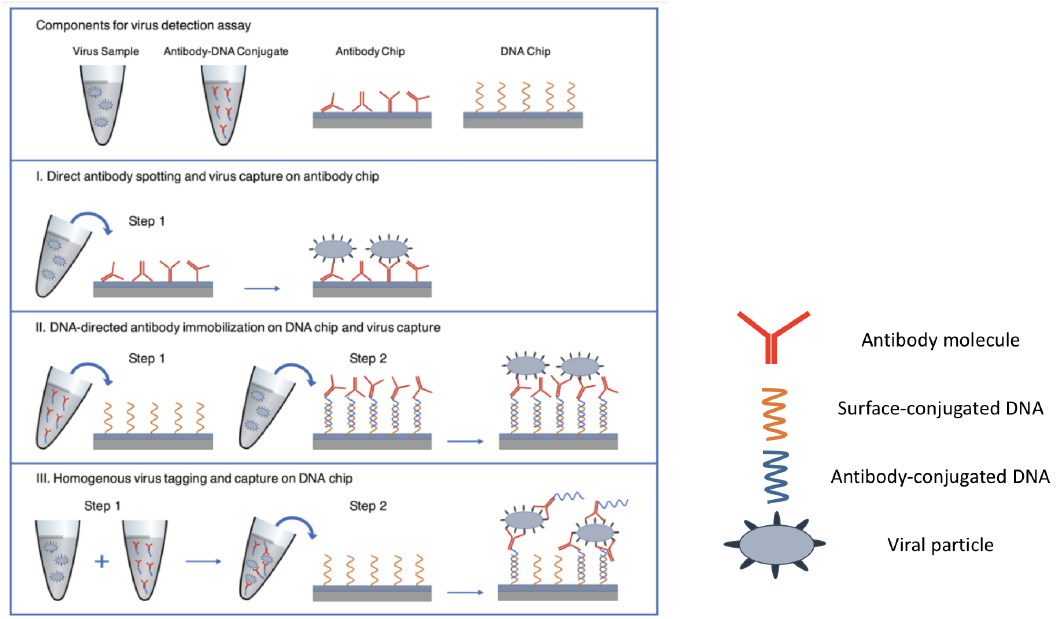
Figure 5. Three different approaches for virus capture on the SP-IRIS chip surface. (I) Direct antibody spotting (II) DNA- directed antibody immobilization (III) Homogenous virus tagging in solution with antibody-DNA conjugates. Figure adapted with permission from [88]. Copyright (2021) American Chemical